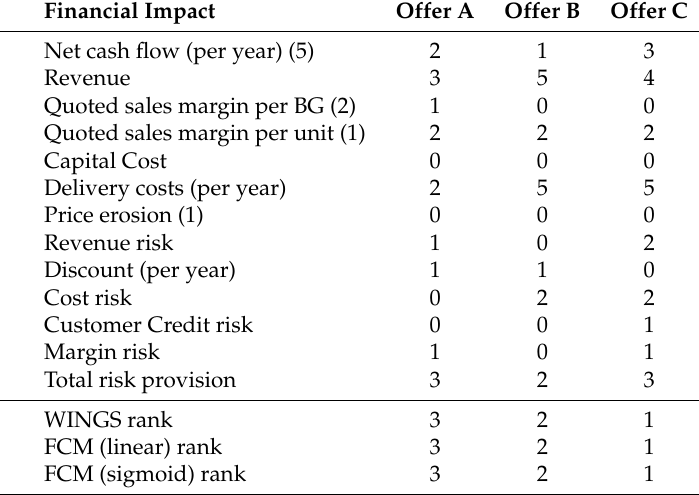
Table 2. Comparison of FCM and WINGS—financial impact rank. Financial